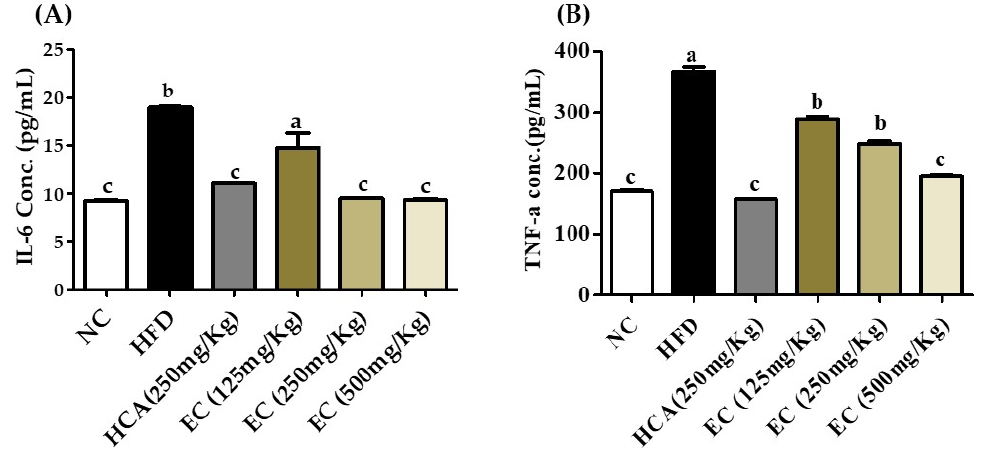
Figure 7. The effects of Ecklonia cava ethanol (70%) extract (ECE) on pro-inflammatory cytokines in rat plasma after 8 weeks of feeding ND; HFD; and 125, 250, and 500 mg/kg b.w of ECE accompanied by a high-fat diet (HFD). ( A ) IL-6 and ( B ) TNF α . Data are presented as means ± SEM ( n = 8 for each group). Values with different letters present significant differences ( p < 0.05).